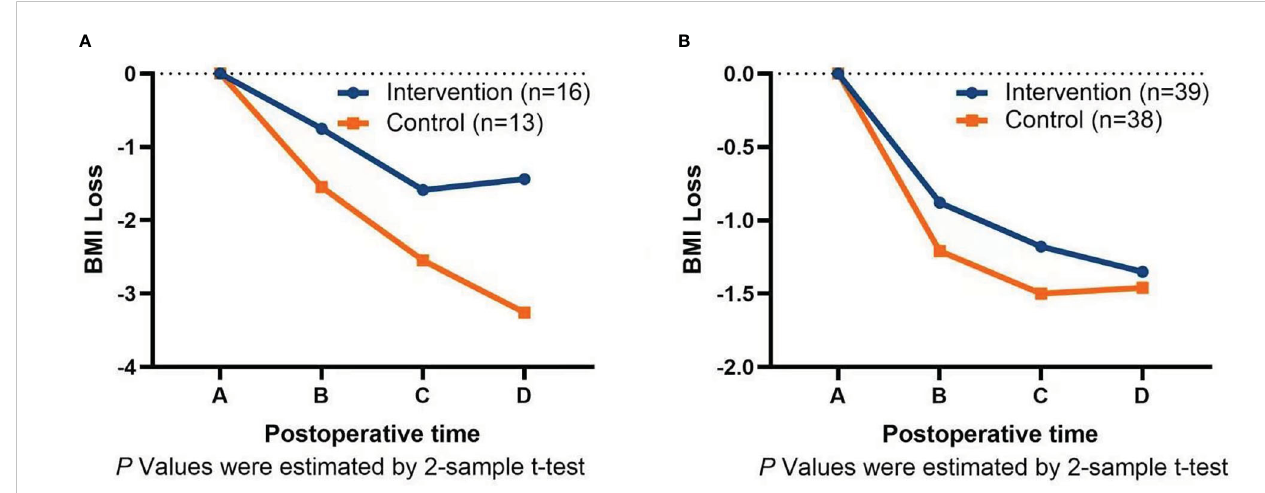
FIGURE 4 (A) Calorie intake chart. (B) Protein intake chart. A=Calorie/protein requirements; B=24-h calorie/protein intake before discharge; C=30 days calorie/ protein intake after surgery; D=60 days calorie/protein intake after surgery.